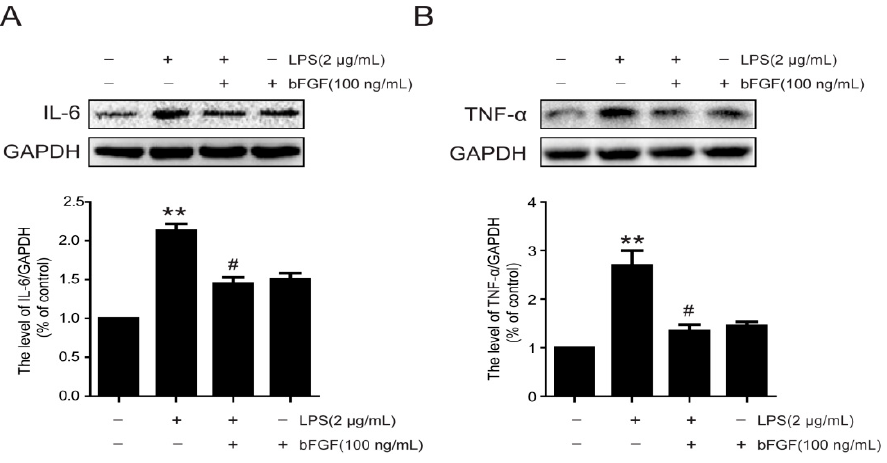
Figure 5. Cont. Figure 5. Cont